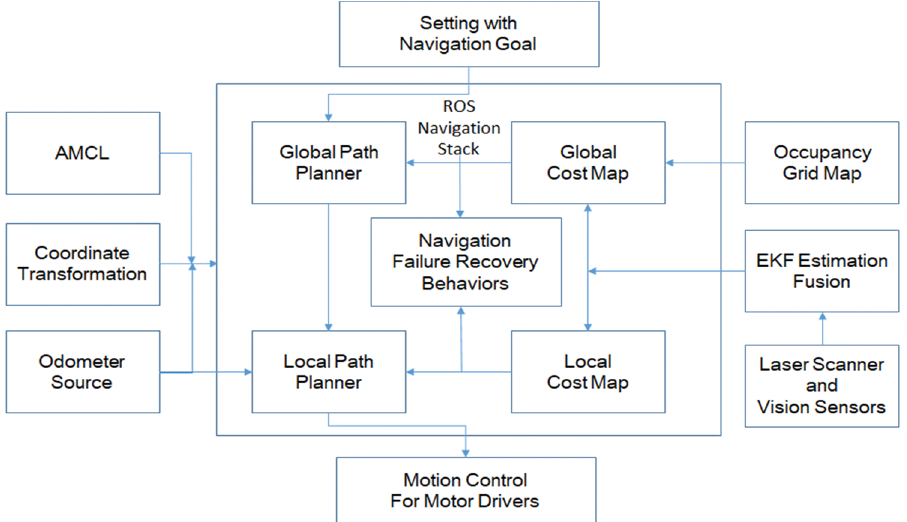
Figure 1. ROS “move base” navigation stack on a robot.